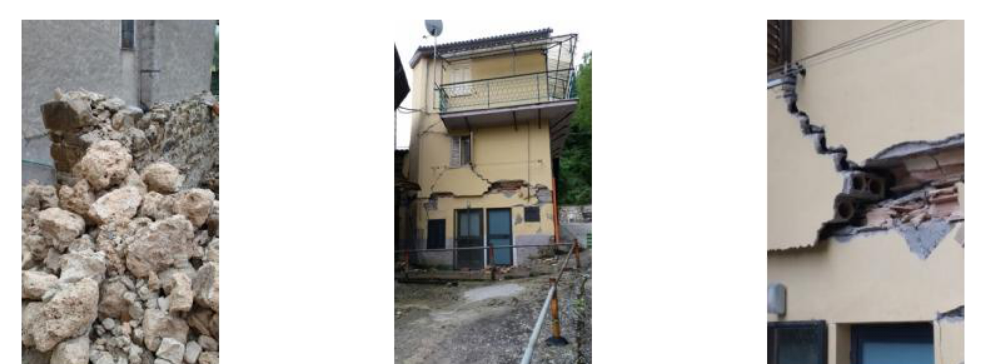
Figure 5 : a) Travertine blocks of a collapsed building, b) Building with two added floors made of hollow bricks, c) Detail of the hollow